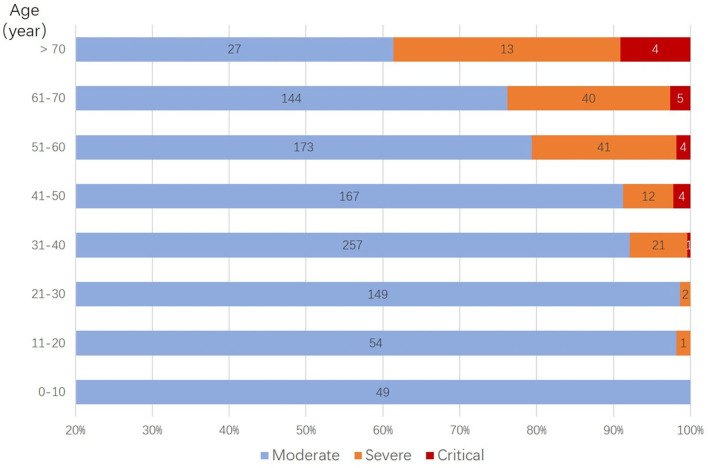
Distribution of deteriorated patients in different age groups. Stratified by age, more deterioration was observed with older age groups, in which cases older than 50 years have a significantly higher percentage of deterioration case (p < 0.001).